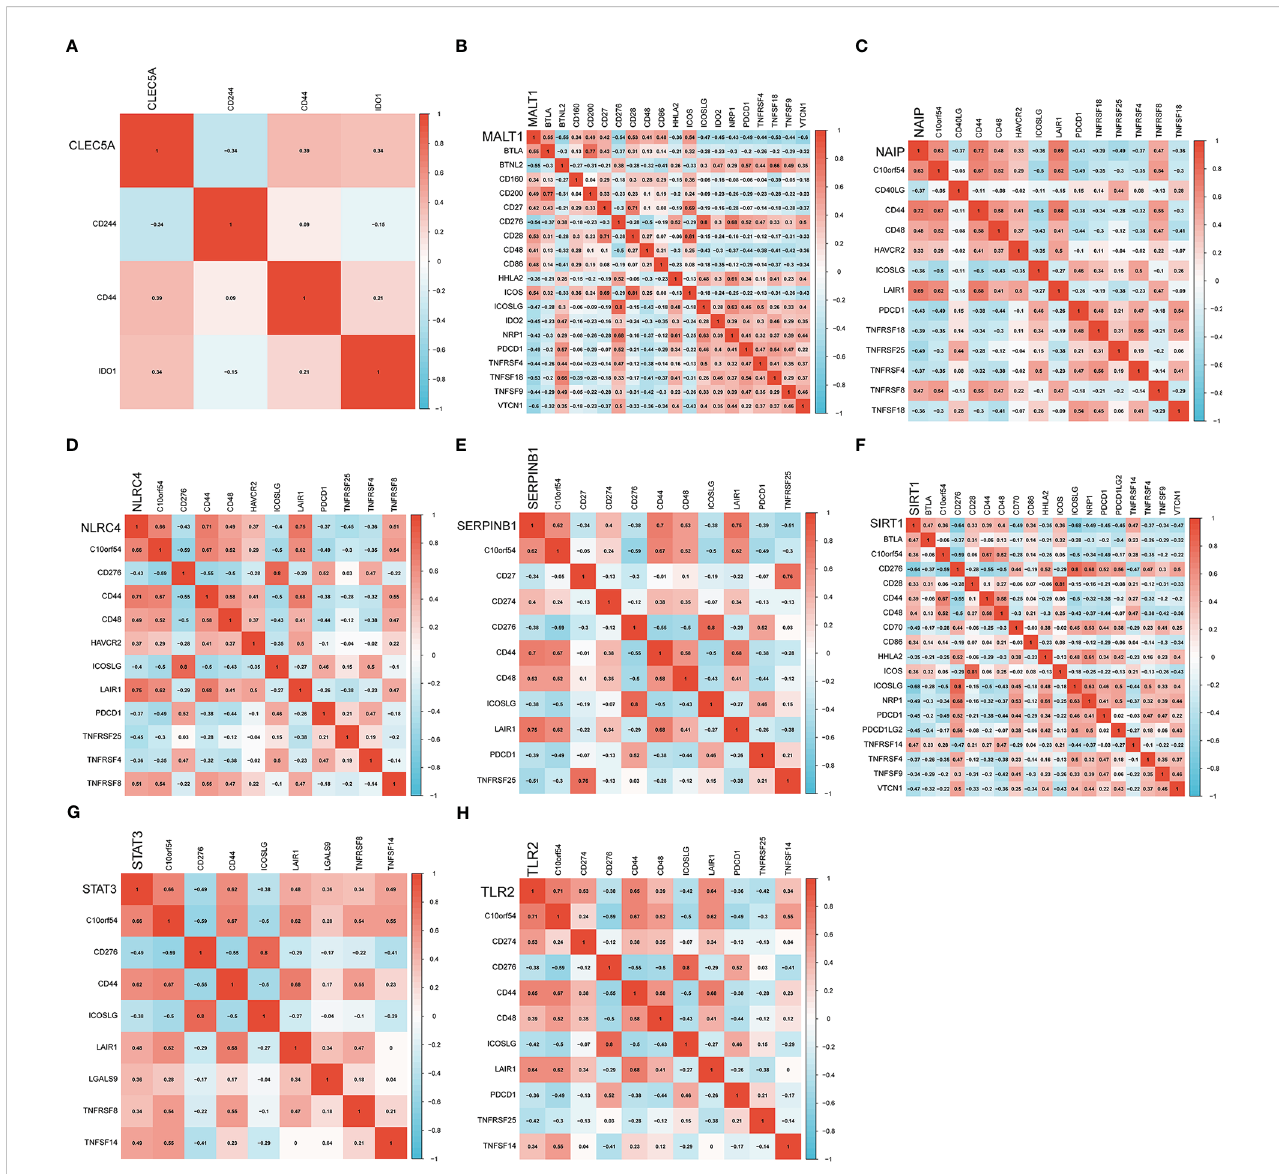
FIGURE 8 Heatmap of the association of eight genes with immune checkpoints. (A – H) are correlation heatmaps with signi fi cant associations between diagnosis- related genes (CLEC5A, MALT1, NAIP, NLRC4, SERPINB1, SIRT1, STAT3 and TLR2) and immune